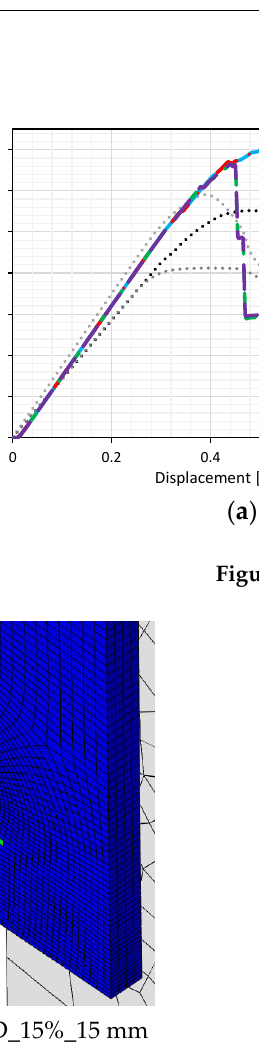
Figure 18. Final shear damage distribution for 15 mm of cover for the double-lap test, with re- duced/full integration (RED/FULL) with 15% and 80% residual compressive stress.